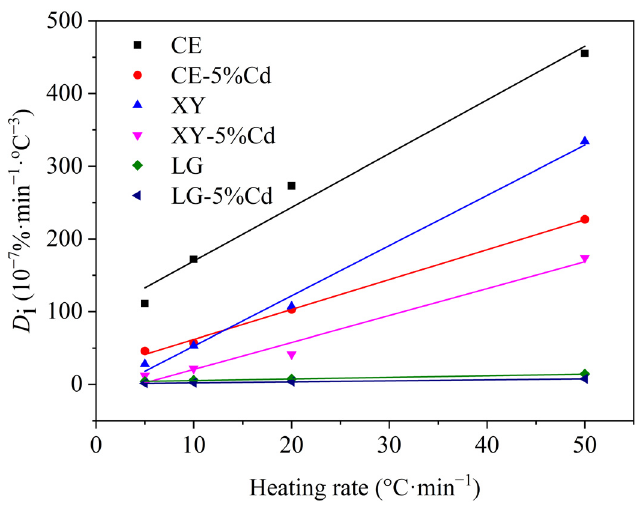
Figure 2. Devolatilization index ( D i ) for three model components and their Cd-concentrated samples.